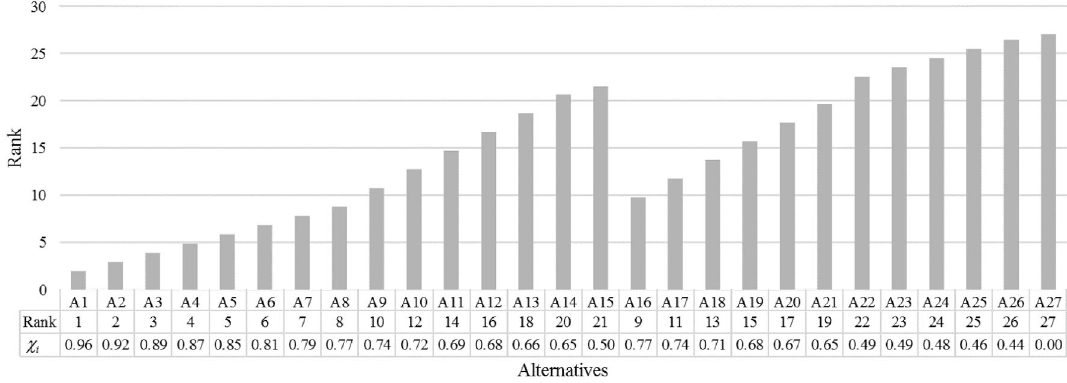
Figure 11. Objective ranks of the feasible